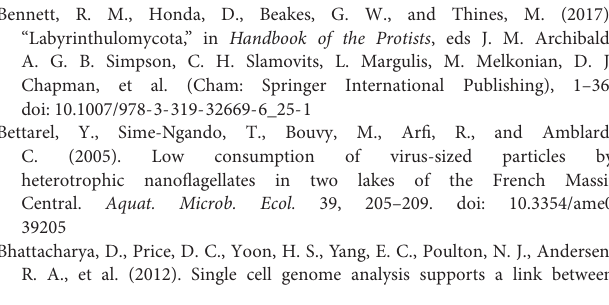
Supplementary Figure 1 | (A–F) Phylogenetic trees of 18S rRNA genes from SAGs from this study with closest relatives. Leaves representing sequences from this study are colored blue (Boothbay Harbor, Gulf of Maine) or yellow [Blanes Bay Microbial Observatory, Mediterranean Sea (BBMO)], and outer circles indicate SAGs that contained either a virus found in SAGs from multiple phyla (inter-phylum), viruses with similar sequences found in more than one SAG (shared virus), and singleton viruses found only in the indicated SAG (singleton virus). Supplementary Figure 2 | Phylogenetic comparison of microvirus VP1 genes from microvirus genomes identified in picoeukaryote SAGs from the Gulf of Maine to other microvirus VP1 genes. In some cases, multiple microvirus contigs were identified within the same SAG, so sequences from this study are indicated in the inner bar, and the node text indicates “(SAG identifier)-(contig number)”. Supplementary Figure 3 | BLAST alignment of contigs from the largest cluster of viral sequences with the longest member of the cluster. Colors on the x -axis indicate the phylogeny of each SAG from which the contigs came. Supplementary Table 1 | Information about samples used for this study. Supplementary Table 2 | Information about protist SAGs used in this study. This includes SAG ID (“sag”), sample ID (“plate”), sampling location (“Location”), lifestyle as determined by sort gate (“Lifestyle,” Heterotroph: non-plastid containing, Phototroph: plastid containing), assembly length (“total_len_bp”), mean contig length (“mean_contig_len”), and total contigs per SAG (“contig_count”) and counts of contigs assigned to bacterial, eukaryotic and viral categories. Supplementary Table 3 | Information about sequences from eukaryote SAGs identified as viral. This includes contig (“contig”), contig nucleic acid length (“length_na”), sample plate (“plate”), SAG id (“sag”), number of open reading frames (“number_of_orfs”), percent of open reading frames matching a phage gene (“viruscope_pct_phage_genes”), metagenomic virus to bacteria ratio (“viruscope_metag_vbr”), probability of sequence being viral according to SCGC’s “ViruSCope” pipeline (“viruscope_virus_probability”), viral category according to VirSorter (“virsorter_category”), identity according to VirSorter (“virsorter_id”),